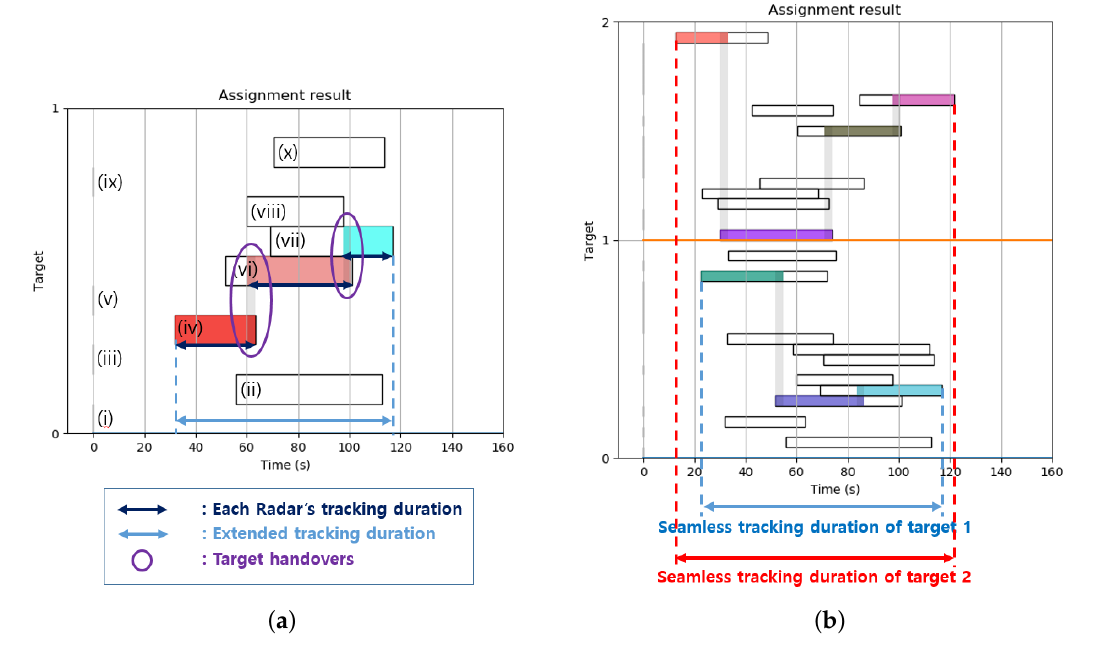
Figure 5. Optimal scheduling assignment results obtained using simple local-scale model. ( a ) One target and 10 radars. ( b ) Two targets and 20